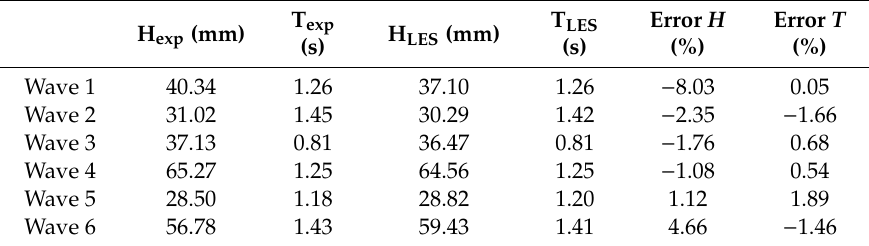
Table 8. Comparison of the wave height and period of the resultant wave between the experimental and LES model, and the error between